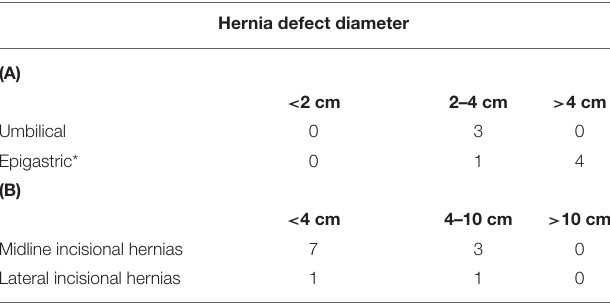
TABLE 1 | (A) Distribution of primary ventral hernias according to the EHS classification (9), (B) Distribution of incisional hernias according to the EHS classification